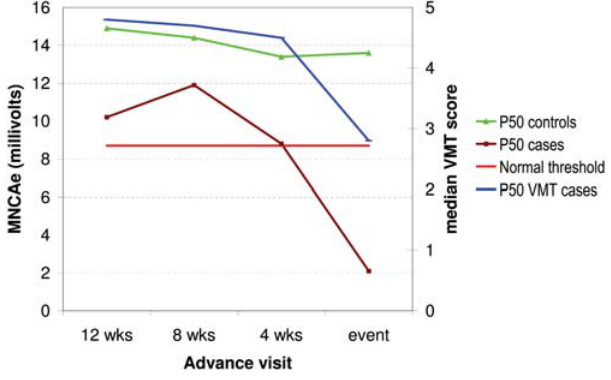
Figure 1. Trend in sensory amplitude in the sural nerve prior to a sensory impairment event detected by monofilaments (case nerves: n=6; control nerves: n=14). ‘Cases’ are nerves with new sensory impairment by monofilament (MF) test at time ‘0’; ‘controls’ are nerves without any clinically detectable sensory impairment during follow-up; P50=median value; normal threshold refers to the specific parameter tested (here SNC amplitude).